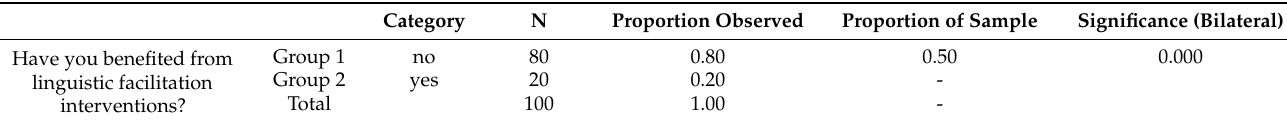
Table 2. Binomial test on linguistic facilitation.